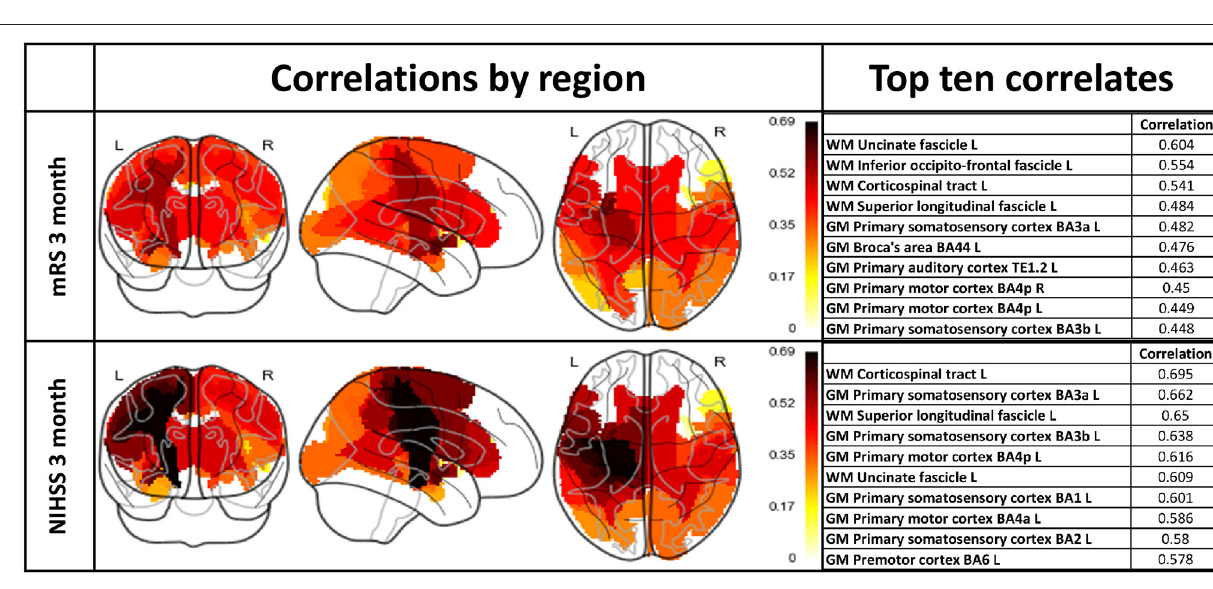
Frontiers in Neurology | www.frontiersin.org